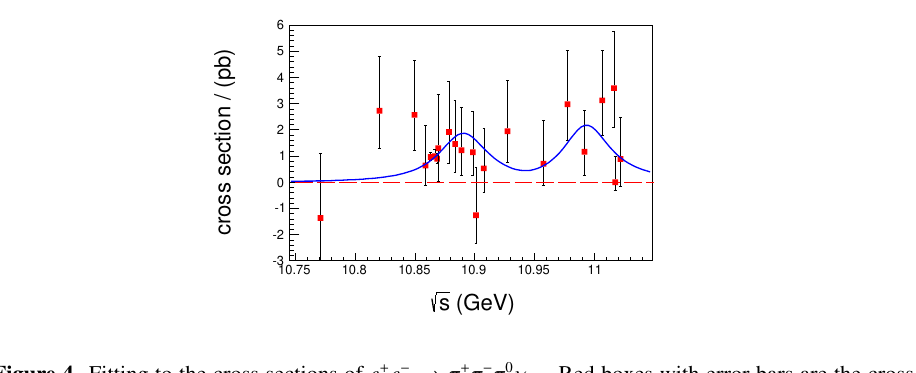
Figure 4. Fitting to the cross sections of e + e − → π + π − π 0 χ bJ . Red boxes with error bars are the cross sections of e + e − → π + π − π 0 χ bJ and solid blue curve is fitting